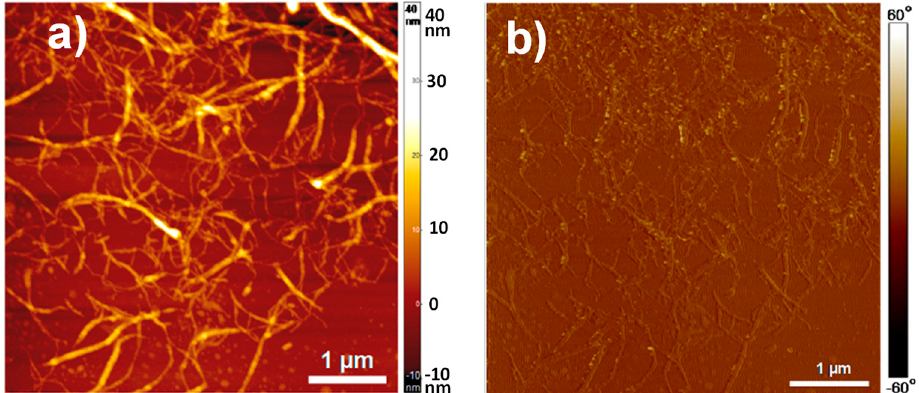
Figure 3. ( a ) Atomic force microscopy topography and ( b ) phase images of cellulose nanofibers used to reinforce the CNF-filled CHI composite